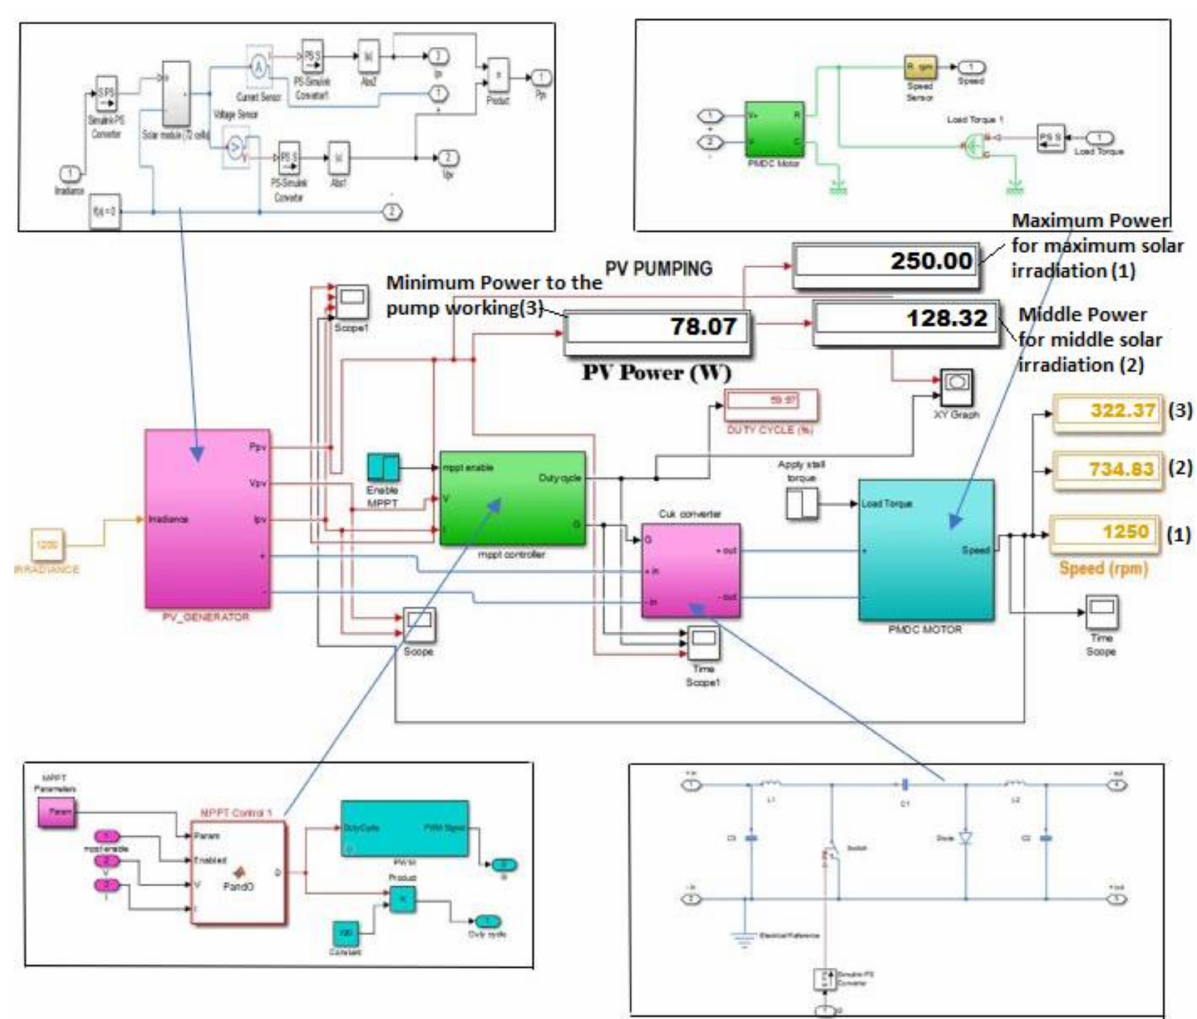
Figure 20. Intelligent block diagram based on MPPT and